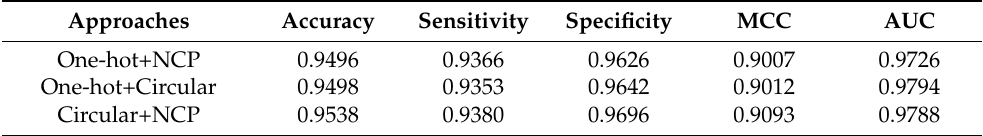
Table 5. Evaluation of effectiveness of different feature combinations using M. musculus species.